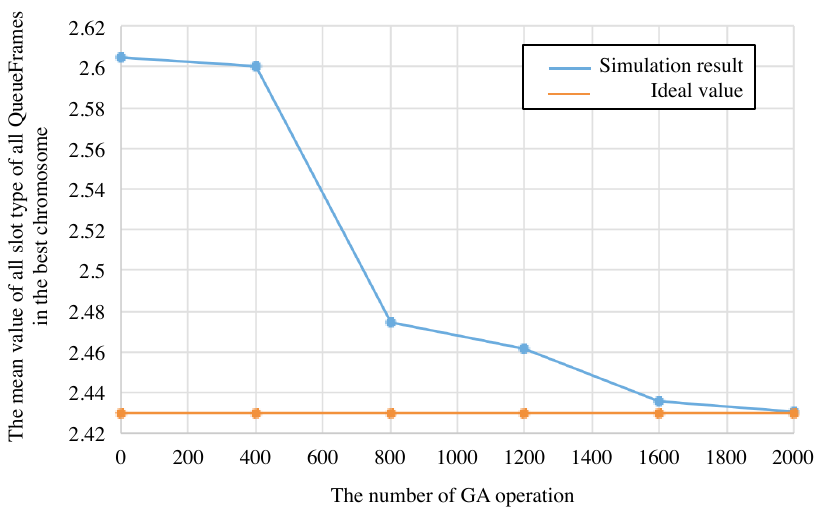
Figure 12. Comparison between the mean value of slot type of all QueueFrames between the best chromosome and ideal